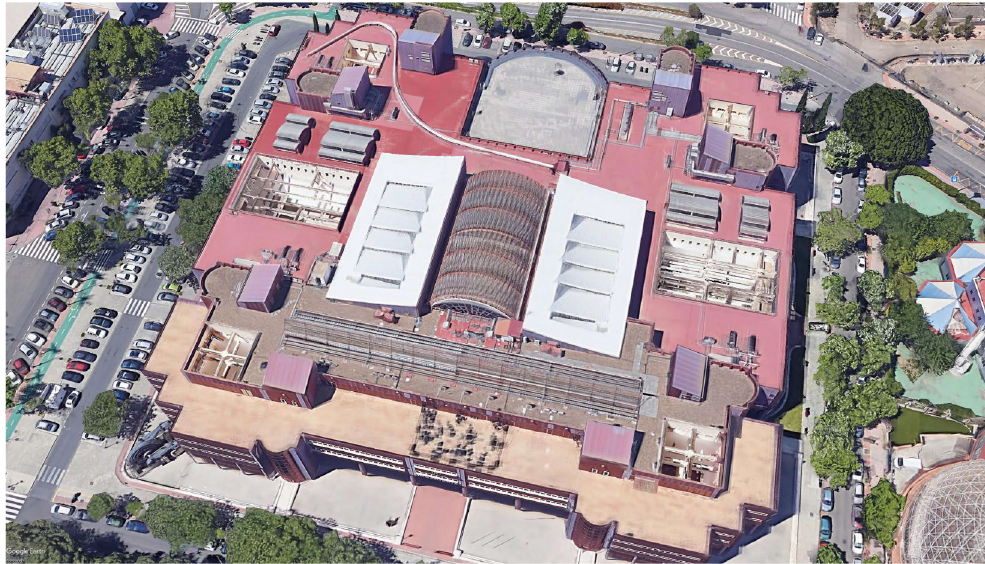
Figure 8. Aereal view of the track installed at the upper left corner of the roof of the School of Engineering of the University of Seville (obtained from Google Maps).